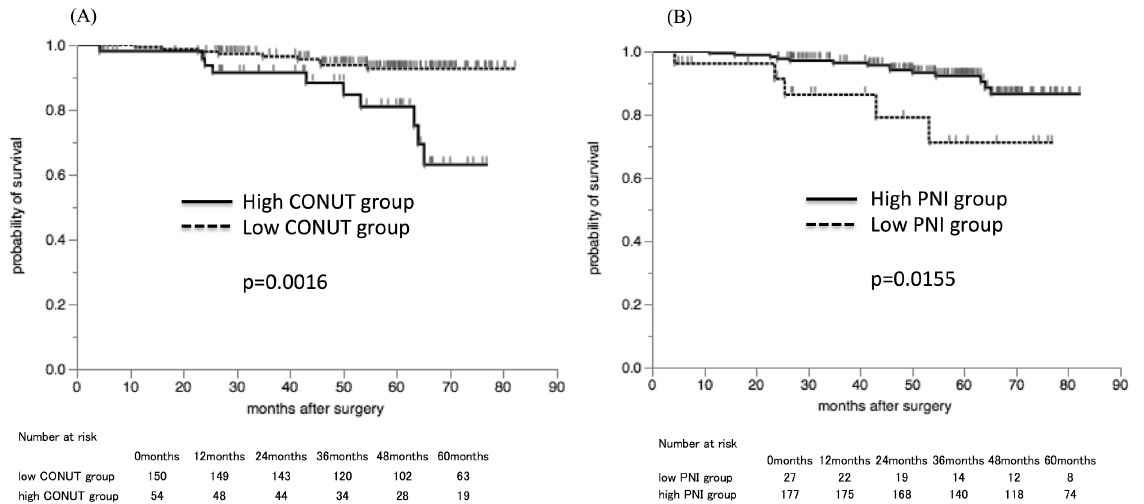
Fig 3. The Kaplan-Mayer survival curves for the cancer-specific survival (CSS). A) The survival curves according to the controlling nutritional status (CONUT) score. The cancer-specific survival rates were significantly worse in the high CONUT group compared to the low CONUT group (p = 0.0016). B) The survival curves according to the prognostic nutritional index (PNI). The cancer-specific survival rates were significantly worse in the low PNI group compared to the high PNI group (p = 0.0155).